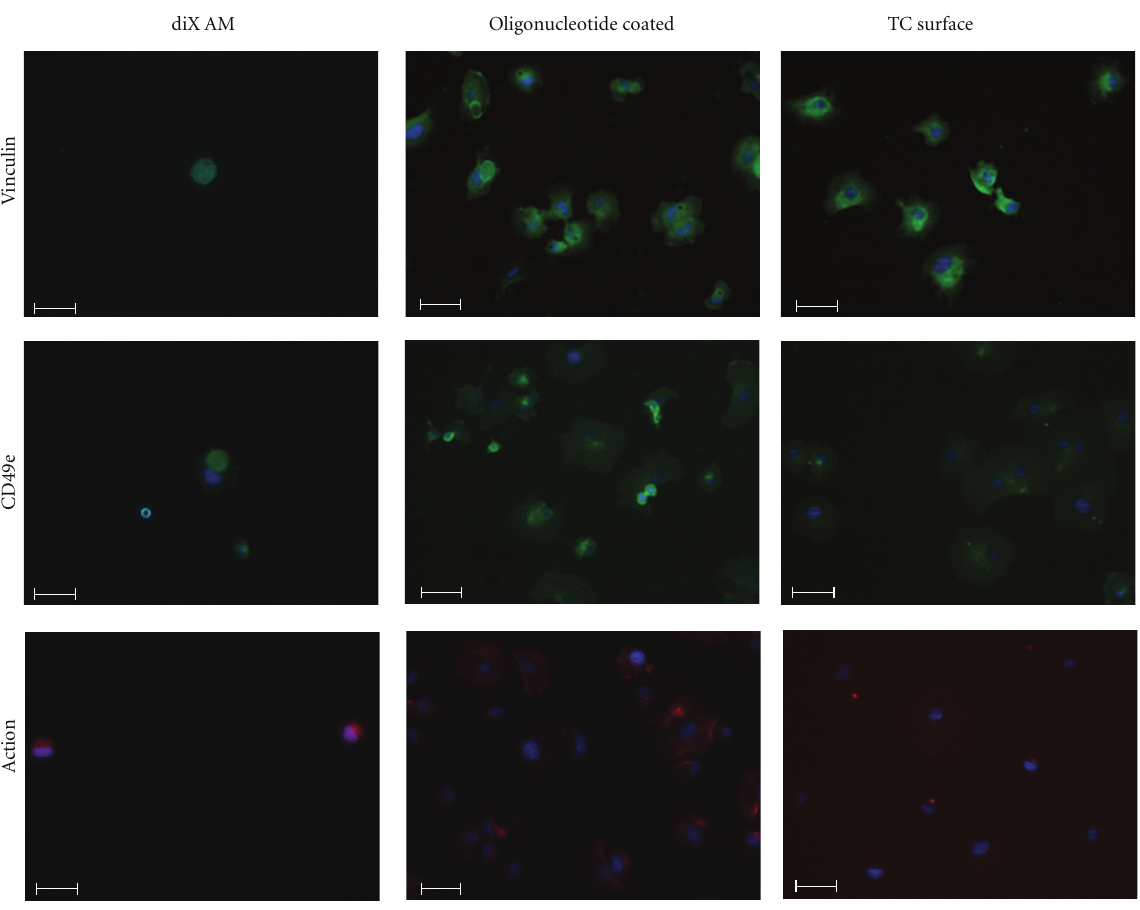
Figure 9: Staining for Vinculin, CD49e and F-Actin of HUVECs after 1 h hour incubation in FCS containing medium under dynamic conditions. Samples were incubated with 0,05 ∗ 10 6 cells in medium containing FCS. Nonadherent cells were removed before staining. Scale bar equals 50 μ m. Nuclei are stained with DAPI